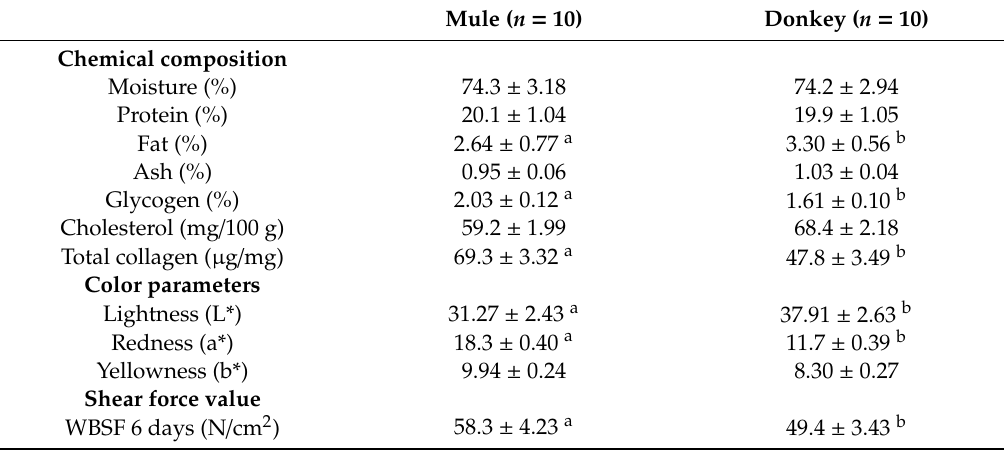
Table 2. Chemical and physical characteristics of muscle Longissimus thoracis (means ± SE) taken from mule and donkey carcasses. Mule ( n =